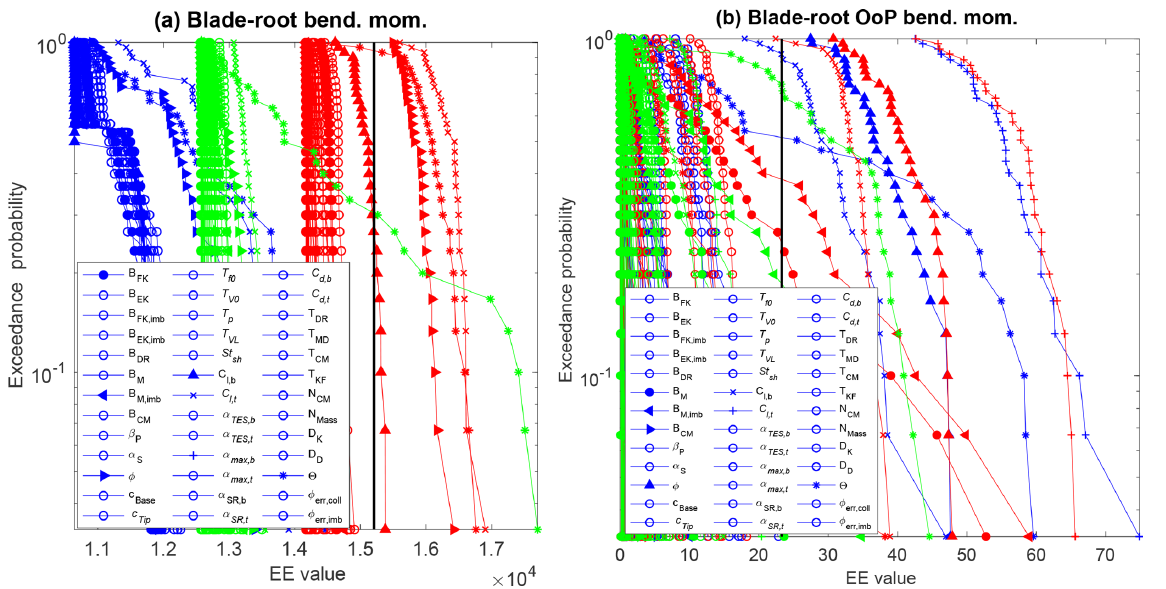
Figure 18. EE-value exceedance probability plots for the blade-root bending ultimate moment (a) and blade-root OoP bending fatigue moment (b) . Each line represents a different input parameter and wind speed bin (blue is below-rated speed, red is near-rated speed, green is above-rated